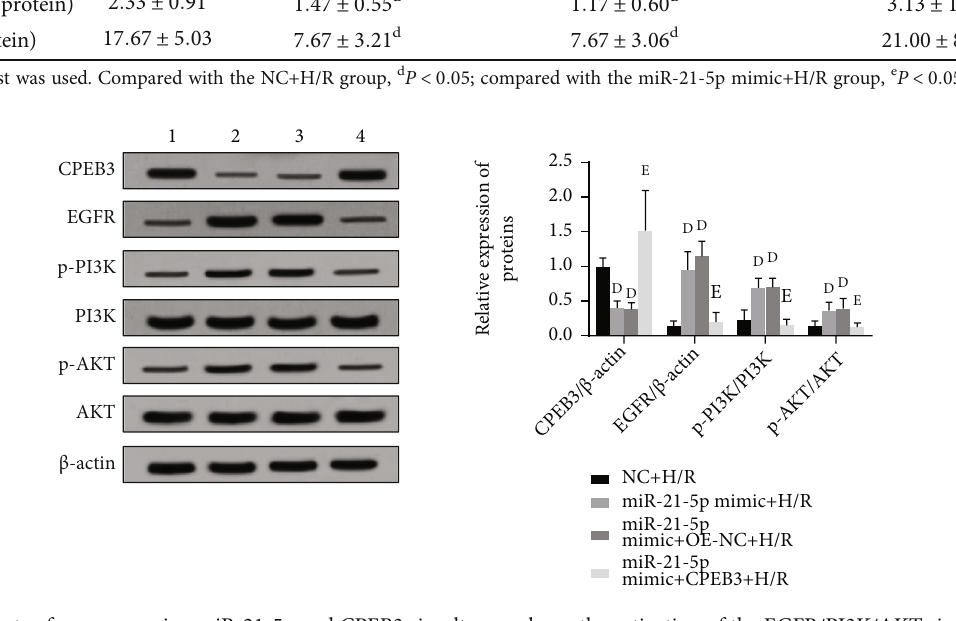
Figure 7: The e ff ects of overexpressing miR-21-5p and CPEB3 simultaneously on the activation of the EGFR/PI3K/AKT signaling pathway ( n = 3 ). The experimental groups are as follows: 1: NC+H/R group; 2: miR-21-5p mimic+H/R group; 3: miR-21-5p mimic+OE-NC+H/R group; 4: miR-21-5p mimic+CPEB3+H/R group. Note: Student ’ s t -test was used. Compared with the NC+H/R group, d P < 0 : 05 ; compared with the miR-21-5p mimic+H/R group, e P < 0 : 05